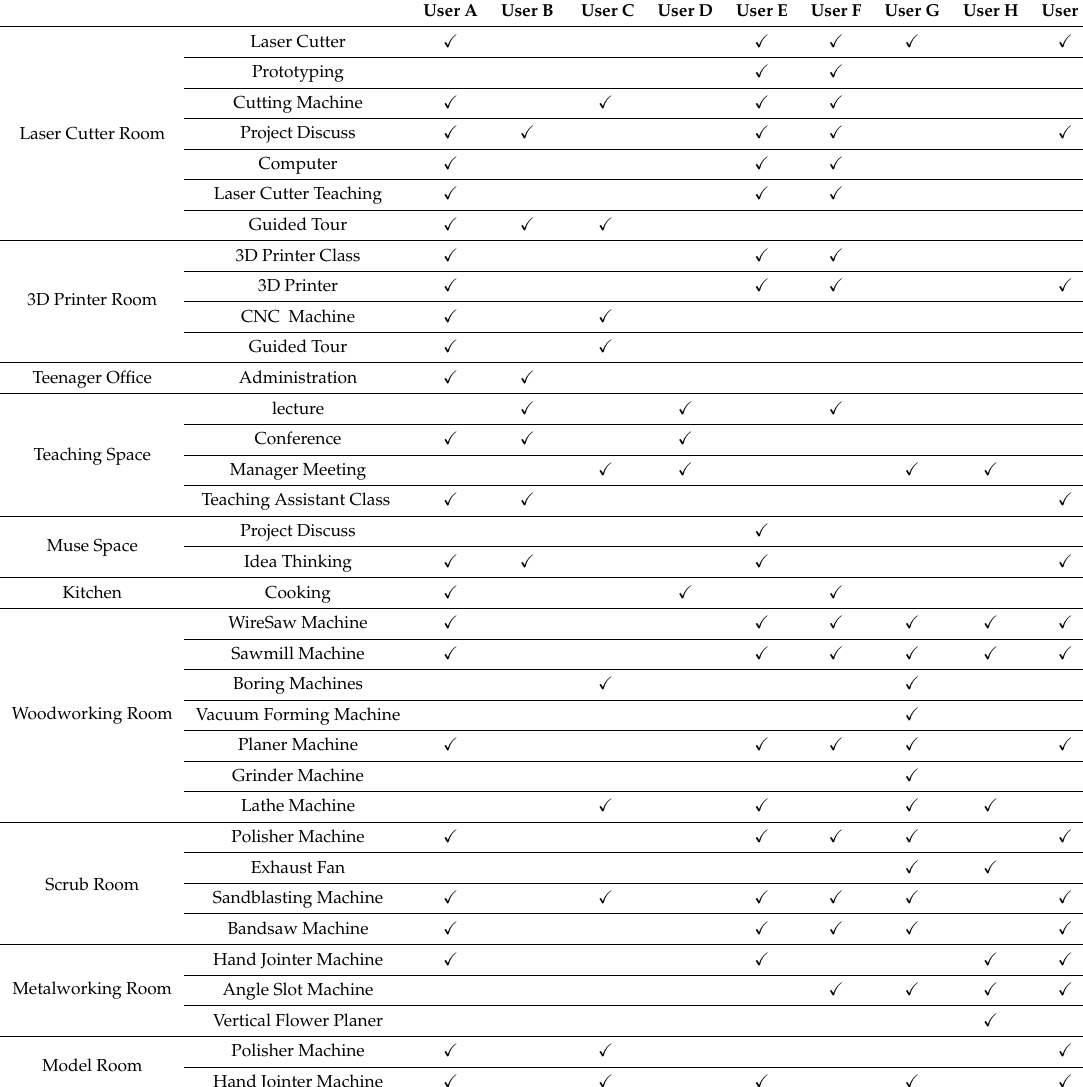
Table 3. Usage in the experiment